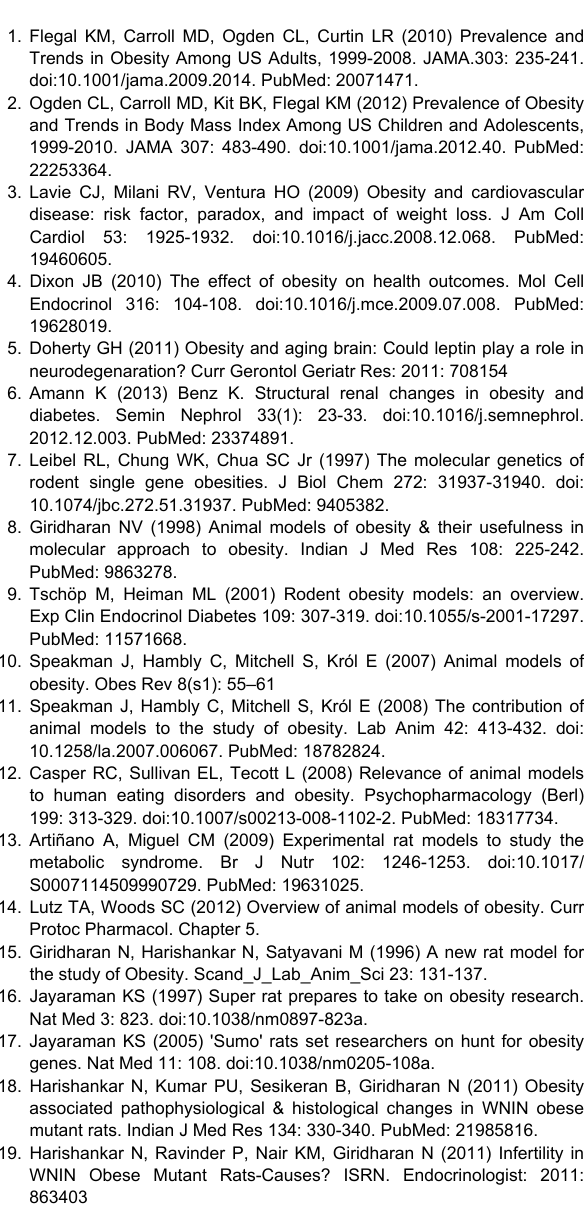
Table S1. F progeny genotype data and corresponding 2 animal body weights (g). A= WNIN/Ob alleles; H= WNIN/Ob alleles & Fisher -344 alleles; - missing data.